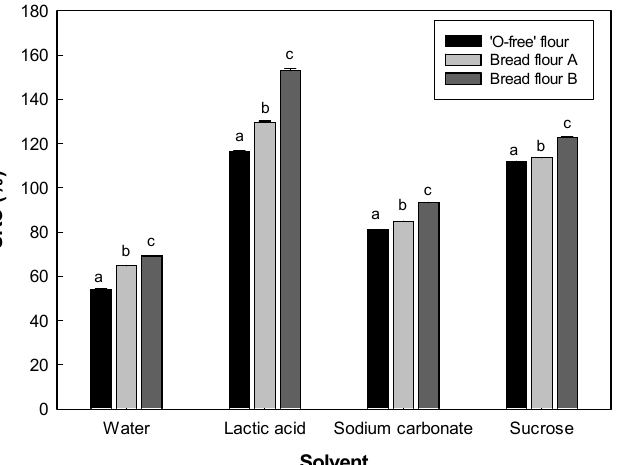
Figure 1. Solvent retention capacity of the flour samples: ‘O-free’ flour, Bread flour A, and Bread flour B. The different letters above the bars are significantly different at p < 0.05, according to Tukey’s HSD test.